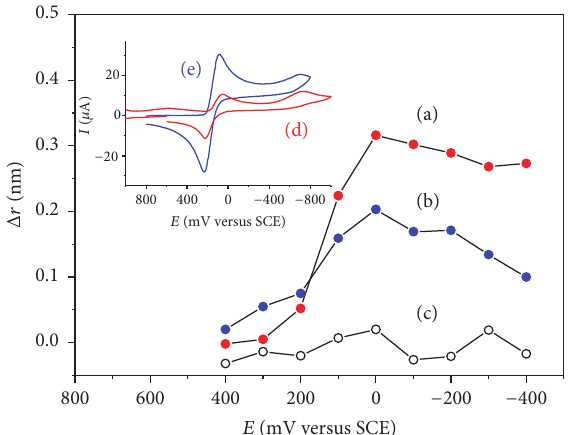
Figure 2: Relationships between Δ r and E revealed from the APBA- grafted HOPG electrodes when reduced in the presence of 1mM Ru(bpy) 2 (phendione) 2+ (a) and 1mM phendione (b). Curve (c) shows the results obtained in the absence of Ru(bpy) 2 (phendione) 2+ or phendione. Inset shows the CVs of 1mM Ru(bpy) 2 (phendione) 2+ (d) and 1mM phendione